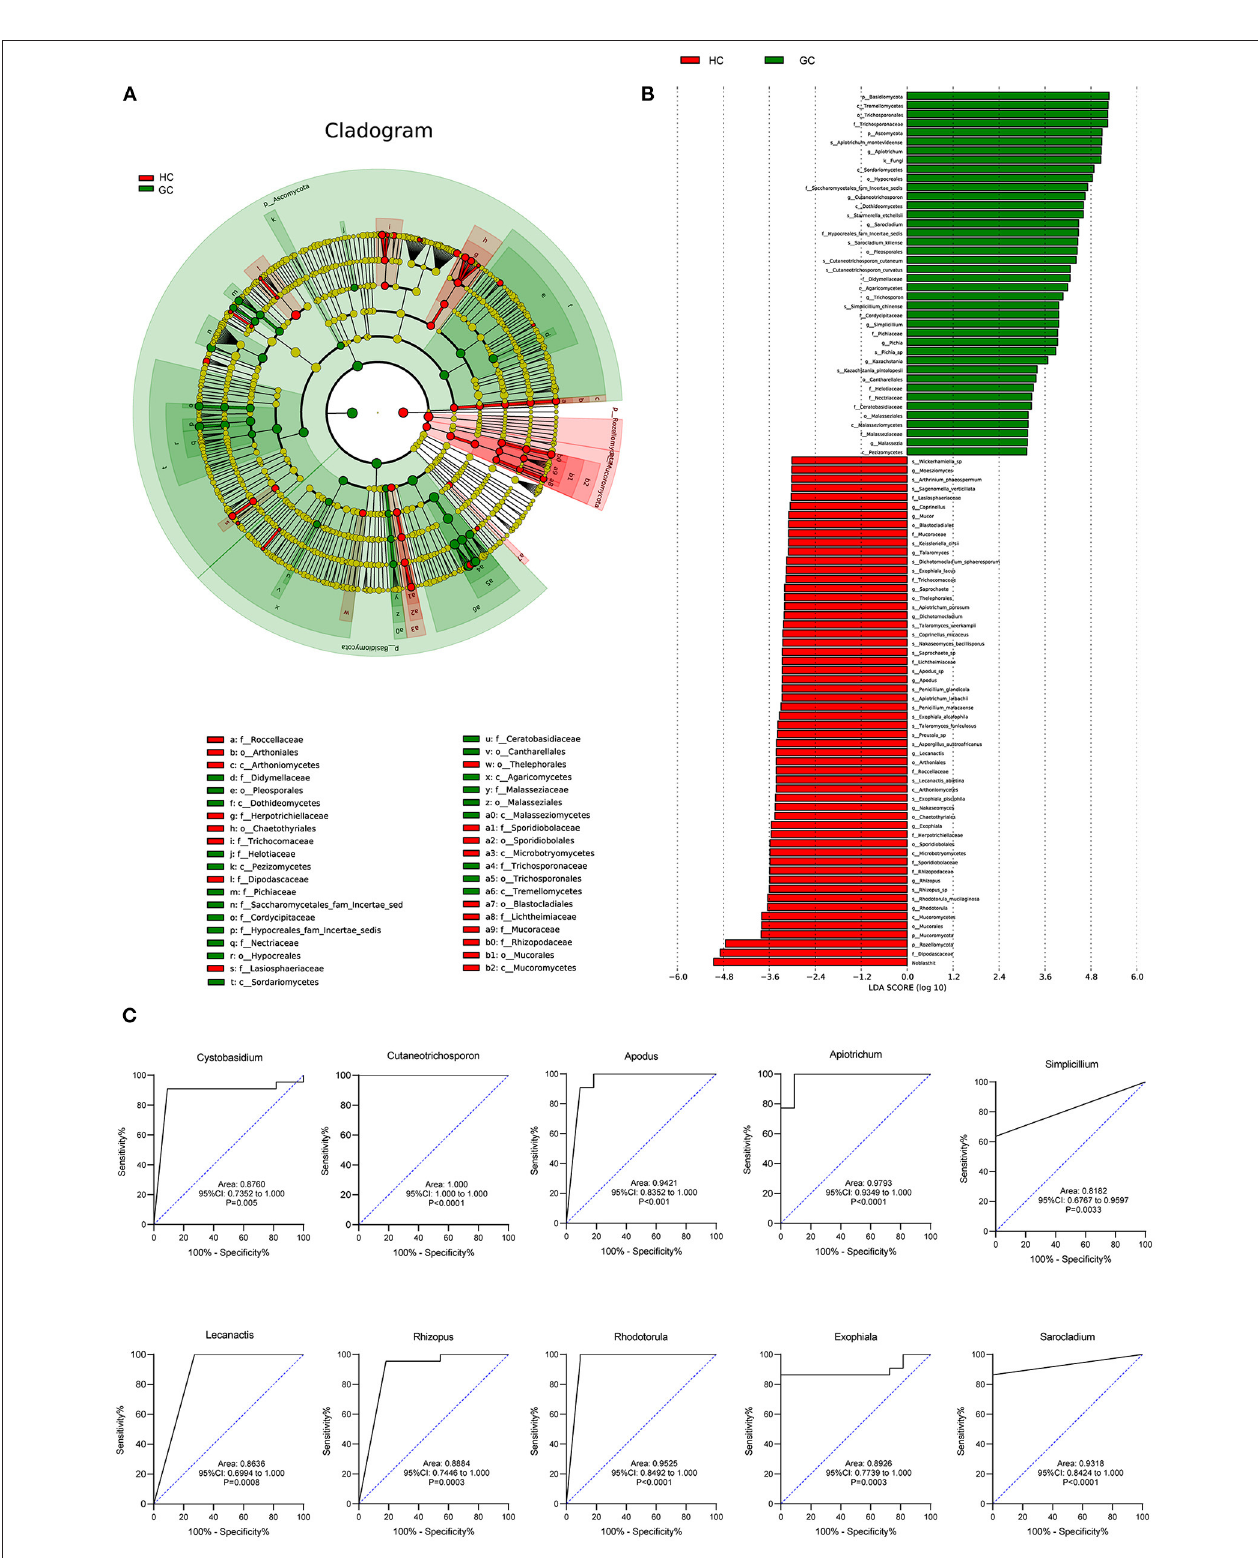
FIGURE 4 | Fungal species as GC diagnostic markers. (A) Cladogram results for the different fungal taxa. Differences were represented by the color of the most abundant class (red, HC; green, GC; yellow, no significance). The diameter of each circle is proportional to the taxon’s abundance. Each ring represents the next lower taxonomic level. (B) LDA score computed by LEfSe analysis between HC and GC groups (LDA score > 3, red, HC; green, GC). (C) ROC curves of the top 10 fungal genus. Diagnostic performance for GC represented by the area under curve was shown.